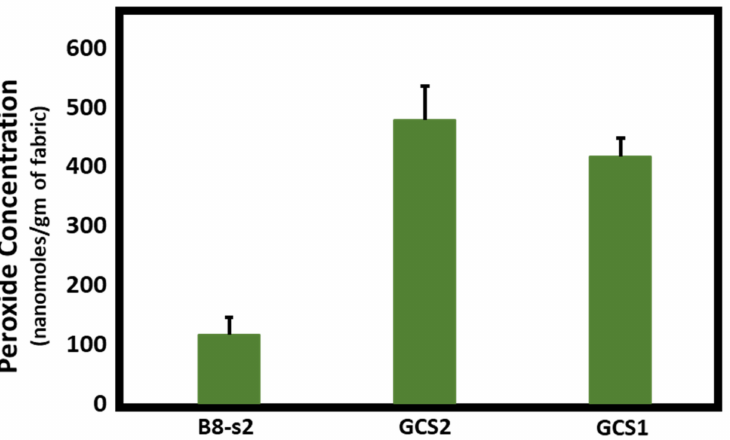
Figure 2. Effects of the addition of copper and ascorbic acid on hydrogen peroxide production. Fabrics (50 mg) were incubated overnight in 2 mL of H 2 O at room temperature. Aliquots were removed and H 2 O 2 content was determined using the ferrous oxidation-xylenol orange assay in quadruplicate, n = 4. Error bars represent SEM. Results were analyzed by ANOVA. Post-hoc (Tukey) test demonstrated significantly higher levels of H 2 O 2 production by 100% cotton woven fabric (bought commercially) treated with both copper and ascorbic acid (GCS2) ( p < 0.001) or by cotton woven fabric treated with ascorbic acid only (GCS1) ( p = 0.002) versus untreated bleached 100% cotton nonwoven (B8-s2)